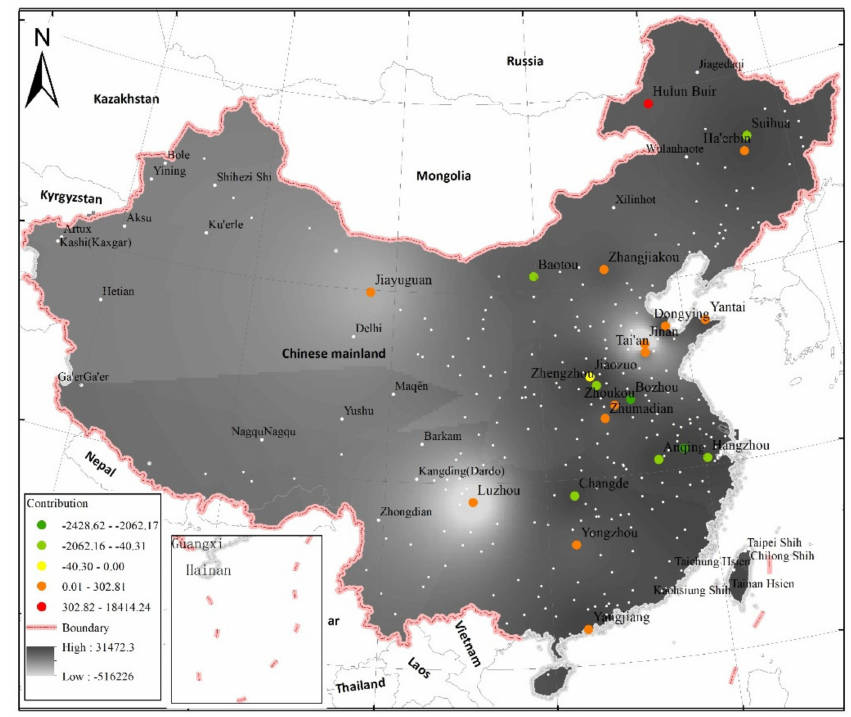
Figure A11. Contribution from the indicator PSI (proportion of science and technology investment to fiscal expenditure in the city) to land-use intensity revealed in the city-based